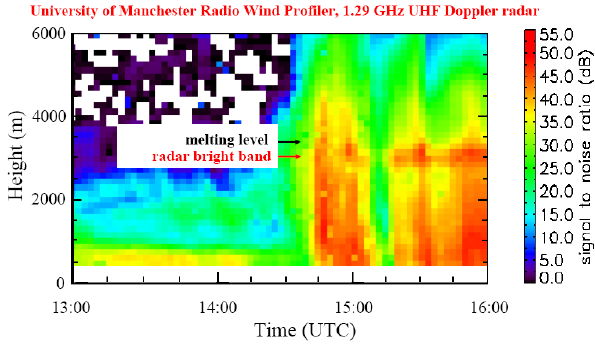
766 Figure 2. Time evolution of radar reflectivity at 1.29 GHz from 13:00 UTC to 16:00 UTC on 767 23 July 2007 as measured by the clear air wind profiler. Arrows indicate the location of the 768 Fig. 2. Time evolution of radar reflectivity at 1.29GHz from melting level and the radar bright band. 769 13:00UTC to 16:00UTC on 23 July 2007 as measured by the clear 770 air wind profiler. Arrows indicate the location of the melting level and the radar bright